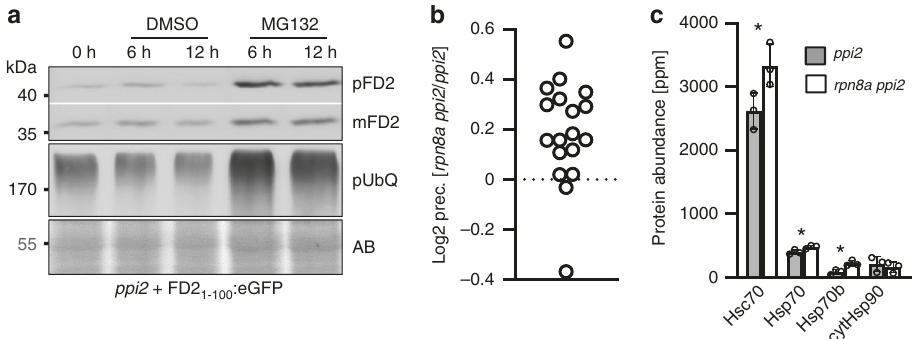
Fig. 7 Functional basis for the observed phenotype. a Protoplast import assay and subsequent extraction of proteins for immunoblotting. Protoplasts were transformed with the precursor of ferredoxin 2 (1 – 100 amino acids) fused to GFP and treated with DMSO and/or MG132 before protein extracts were obtained. Blots were either decorated with the GFP-antibody identifying the precursor of ferredoxin 2 (pFd2) and the mature form of ferredoxin 2 (mFd2), or with a pUbQ antibody identifying poly ubiquitinated proteins (pUbQ). The loading control is presented as amido black stain of the membrane (AB). b ChaFRADIC identi fi cation of N-terminal peptides identi fi ed 18 precursor proteins. The results of relative precursor quanti fi cation by iTRAQ are presented as the Log2-ratio between precursor abundance in the rpn8a ppi2 double mutant compared to ppi2 as the mean value from three biological replicates. For more information about the precursors see Supplementary Data 5. c Abundance of cytosolic heat shock proteins in ppi2 and rpn8a ppi2 mutants determined from three biological replicates. Signi fi cant differences are highlighted by a star ( T -test, two-sided, p -value <